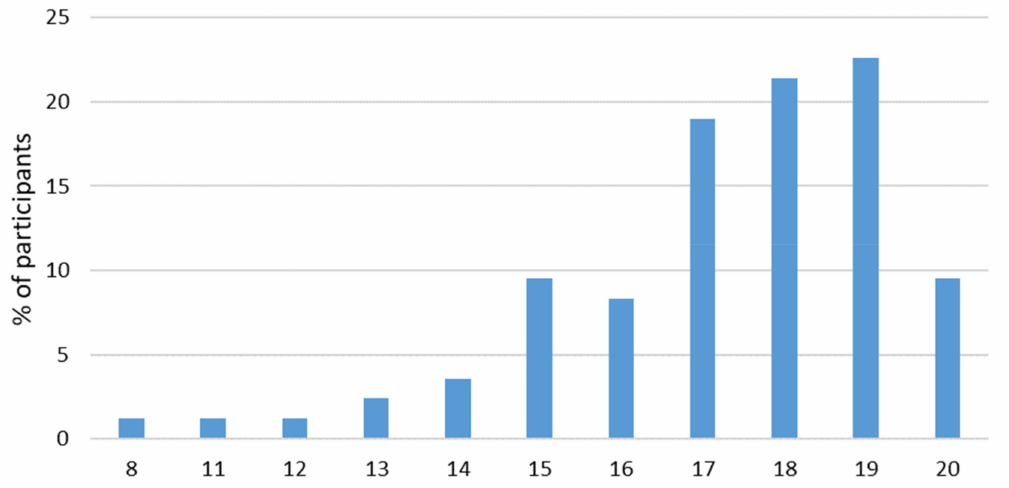
Figure 2. The frequency of FMS scores in total (8–21 points).